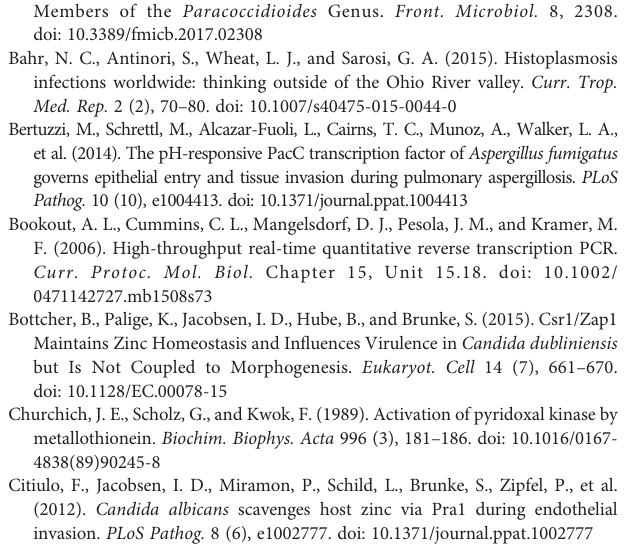
SUPPLEMENTARY FIGURE 1 | Interaction network of genes related to zinc homeostasis. Zap1 was used as input sequence. Zap1: HCBG_03275; Zrt1: HCBG_07321; Zrt3: HCBG_04549; Zrc1: HCBG_00193; Zrc2: HCBG_00193; ZrfG: HCBG_05775 and ZitB: HCBG_07983. Light blue and purple lines are known interactions from experimental databases. Dark green, red, and dark blue lines are predicted interactions from neighborhood genes, gene fusions, and gene co- occurrence. The light green and black lines are the interactions by co-expression and homology of the protein. SUPPLEMENTARY FIGURE 2 | DTPA promotes a Zn depleted environment. (A) In fl uence of DTPA on the growth of H. capsulatum . Optical density was measured at 595 nm. ( B ) Expression level of ZRT1 in the control condition, DTPA and DTPA plus Zn (200 µM). ( C) Expression level of CTR3 in the control condition, DTPA and DTPA plus Zn (200 µM). All experiments were carried out in biological triplicates. The comparisons were made using the Student t test with *p ≤